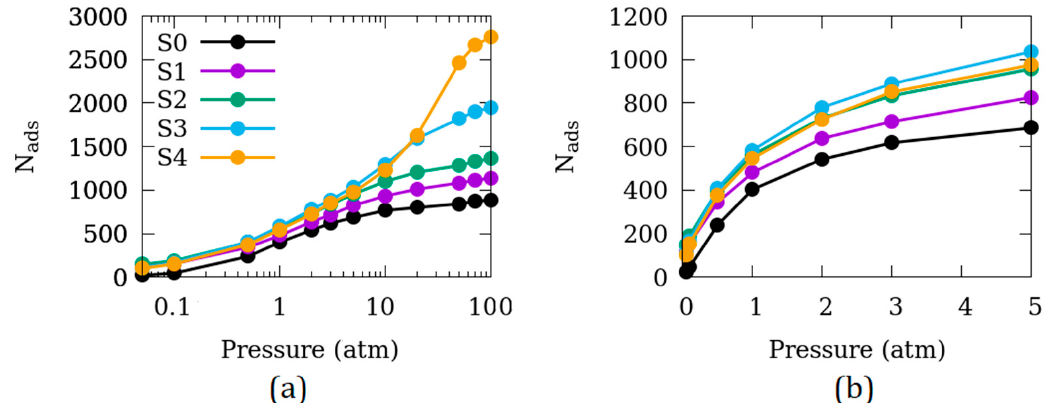
Figure 2. Adsorption isotherms of CO 2 in Mg-MOF-74 over ( a ) wide range of partial pressures up to 100 atm, ( b ) partial pressures relevant to applications. In ( b ) size of the symbols present the largest uncertainty in N ads . Symbols in panel ( b ) have the same meaning as in panel ( a ). In Figure 3, the distribution of the adsorbed CO 2 molecules in the X–Y plane of the system S4 is shown. When all the adsorbed molecules are considered, (Figure 3a), a pattern of random distribution superimposed on a pattern of circular high adsorption points can be seen. When the molecules adsorbed in the inter-crystalline space outside the crystallite in the Z-direction are excluded, a pattern of strong adsorption in the crystallite pores (circular regions of high intensity in Figure 3b) are seen. In addition to the pores, the molecules adsorbed in the inter-crystalline space in the Y–Z plane can be seen making a random pattern (outside the crystallite boundary marked by white lines). The fact that the distribution of molecules in the inter-crystalline space is indeed random can be seen in Figure 3c where only molecules outside the crystallite in the Z-direction are included. Figure 4 shows the distribution of the adsorbed CO 2 molecules in Mg-MOF-74 in terms of the ratio of the number of molecules adsorbed within the crystallite (N c ) to those on the surface of the crystallite and in the inter-crystalline space (N g ). At very low pressures, more molecules are adsorbed on the surface as compared to inside the crystallites. As pressure increases the pores within the crystallite start to fill while the amount of CO 2 adsorbed on the crystallite surfaces increases relatively slowly thereby yielding (N c / N g ) values larger than 1. This ratio increases consistently up to about 2 atm, after which it plateaus for S1 and S2 and decreases again for S3 and S4. The di ff erence in the high pressure behavior between S1 and S2, and S3 and S4, is because of a smaller inter-crystalline space in the former two systems, which saturates with CO 2 molecules at these pressures, whereas the latter two samples with a larger inter-crystalline space can accommodate a larger number of molecules thereby resulting in lower N c / N g ratio at higher